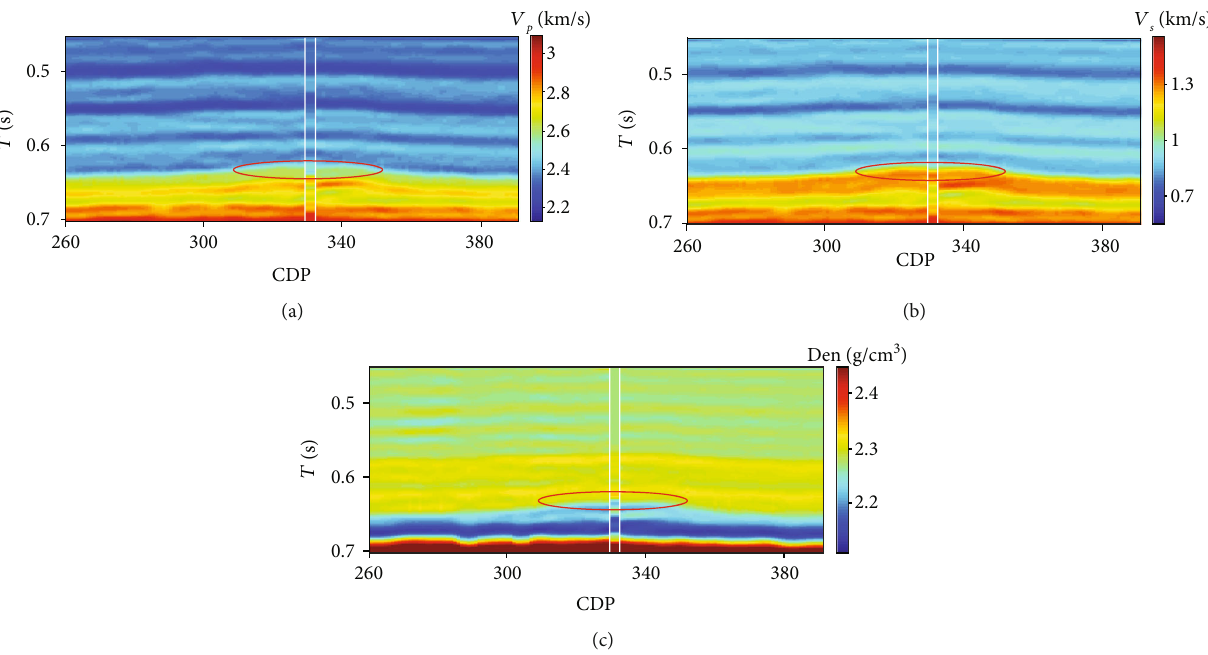
Figure 6: Inversion results based on the exact Zoeppritz ’ s equation. (a) is the section of P-wave velocity, (b) is the section of S-wave velocity, and (c) is the section of density. The real well logs are inserted at CDP 330. The red circle highlights the location of the gas reservoir.